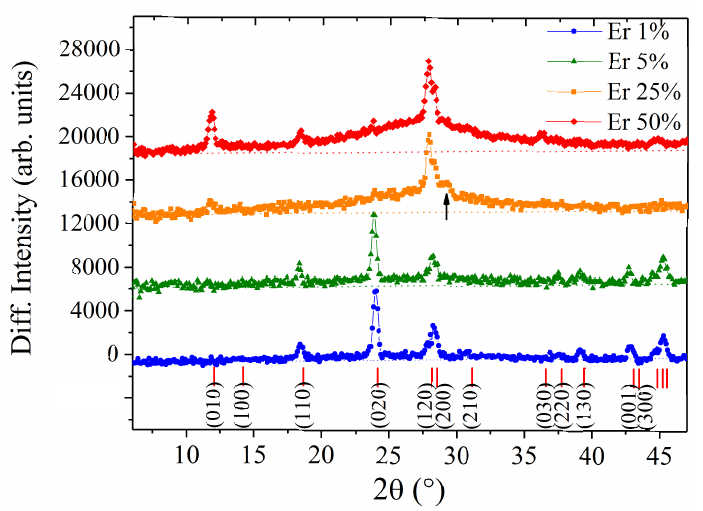
Figure 8. DMC powder pattern, low temperature (40mK)–10K data for four samples. The patterns have been shifted in intensity for comparison. The expected reflections for magnetic structures with k = [ 0,0,0 ] are marked in the figure as red lines. Straight horizontal lines are a guide for the eye referring to the expected flat background. The intensity above this line is magnetic in